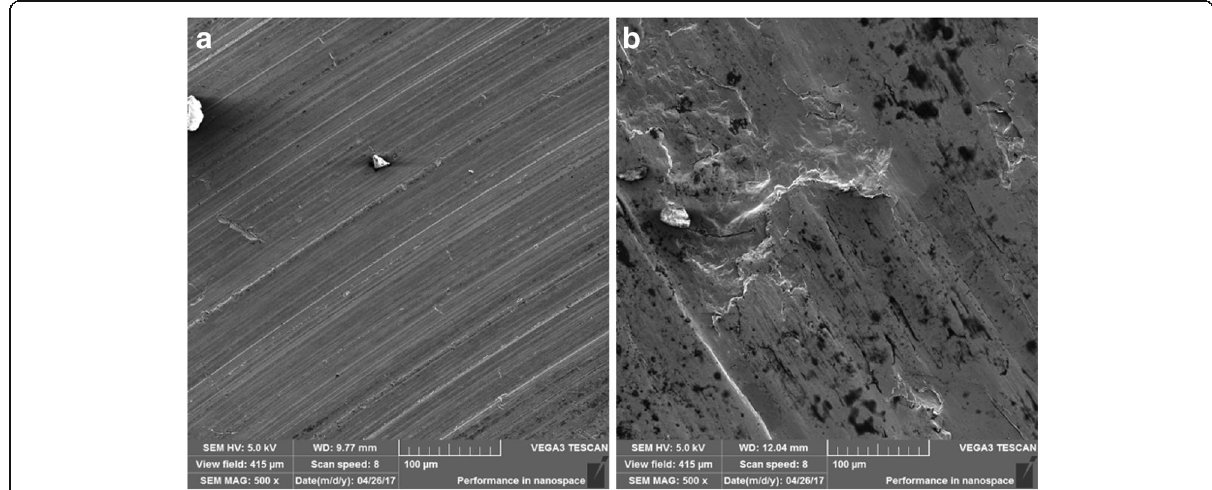
Fig. 9 SEM images of the wear scars for a C16-ZrP-N6 and b C16-ZrP in mineral oils after testing under a load of 80 N and rotation speed of 350